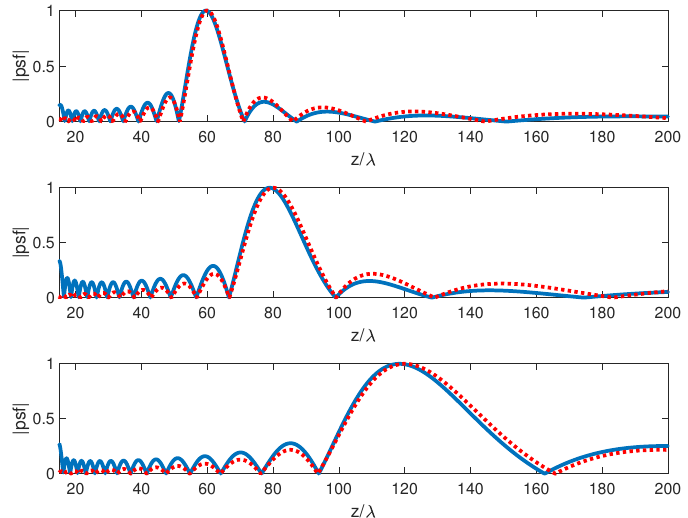
Figure 5. Magnitude of the point spread function for a = 30 λ , z 1 = 15 λ and z 2 = 200 λ . The blue line is psf , while the dotted red line refers to psf h . In the top panel z (cid:48) is 60 λ , in the middle 80 λ and in the bottom 120 λ